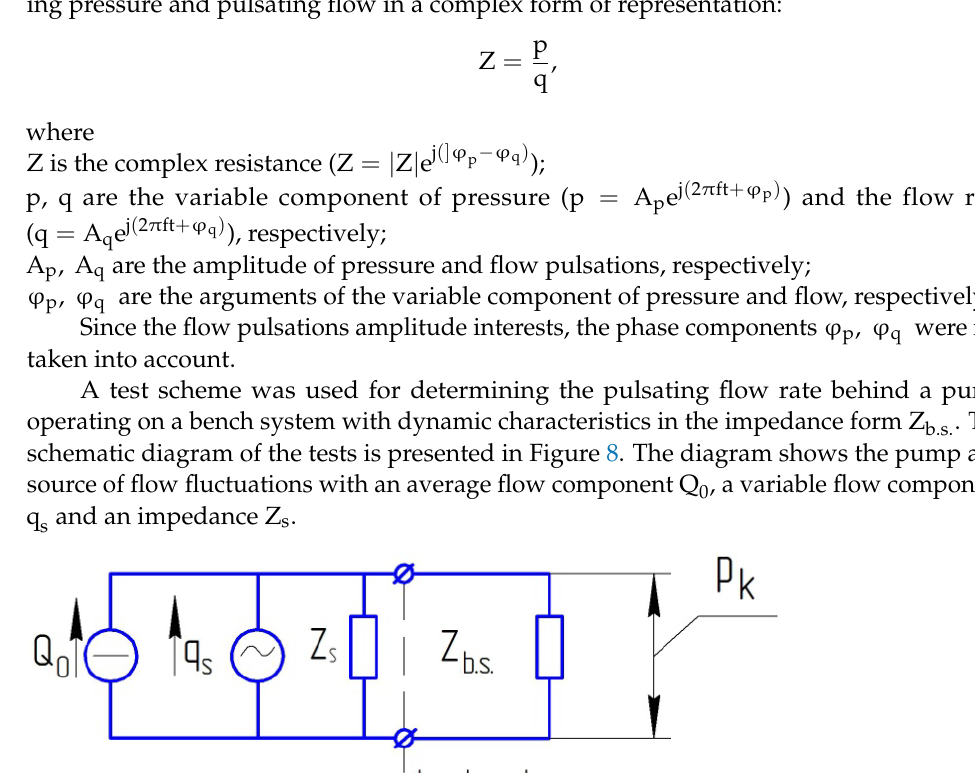
is the variable part of the bench system k